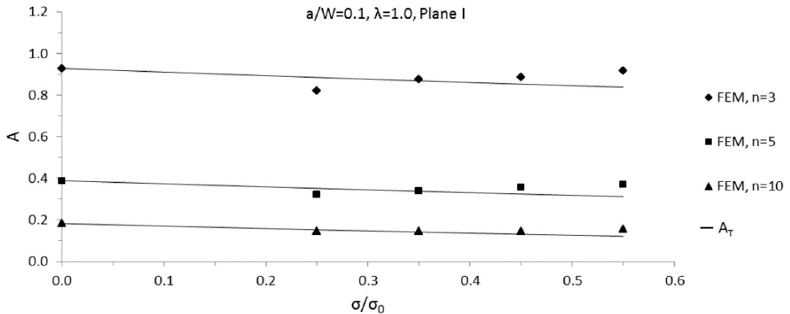
Figure 6. Comparisons of predicted 3D SECP A values with finite element analysis (FEA) data, biaxial ratio λ = 1.0, a/W = 0.1, in plane I.